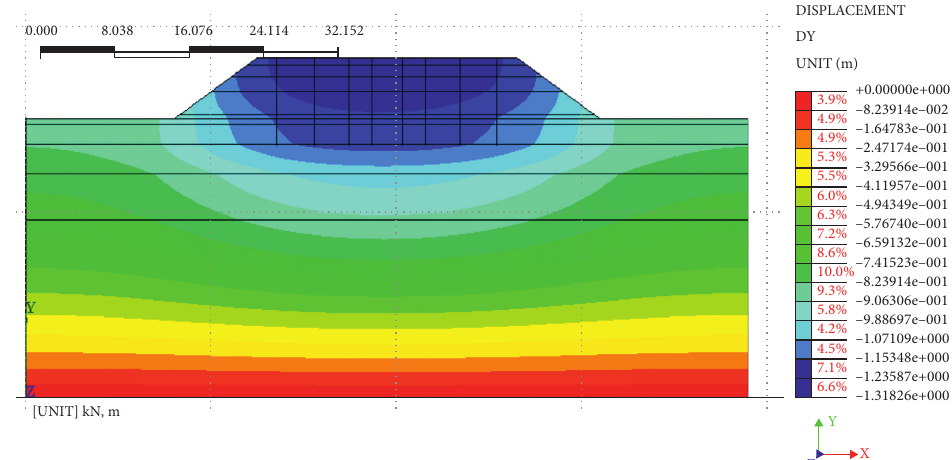
Figure 5: Model results for vertical displacement during subgrade filling.